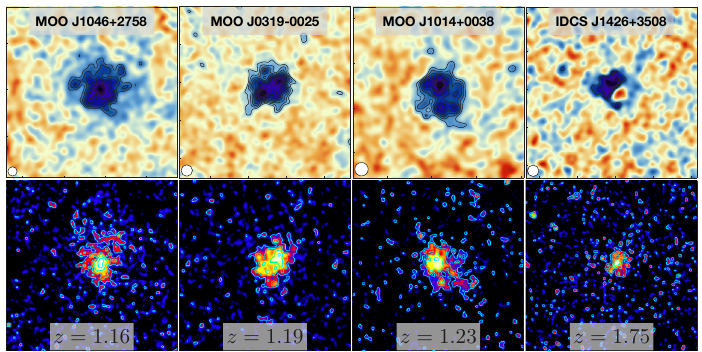
Figure 2. Preliminary SZ (top) and X-ray (bottom) maps obtained with the MUSTANG-2 (far left) and NIKA2 camera at 90 GHz and 150 GHz and the ACIS-I instrument on-board Chandra for four clusters in the MOO-X / SZ sample. Contours in the MUSTANG-2 and NIKA2 maps start at 3 σ with 1 σ steps. Photon count iso-contours are shown in the X-ray maps for visual purposes. We indicate the name and redshift of each cluster in the upper and lower panels, respectively. All maps have a side length of about 4 ⇠